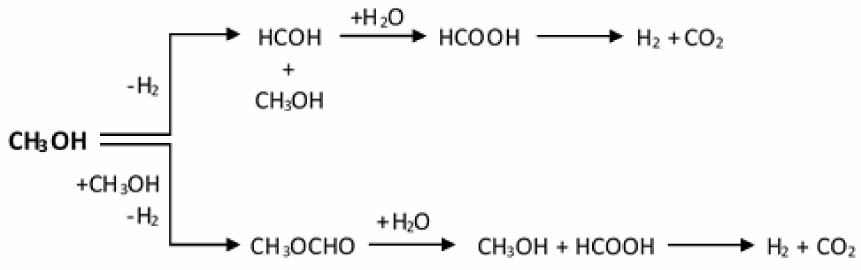
Figure 4. The reaction steps taking place during the steam-reforming of methanol process